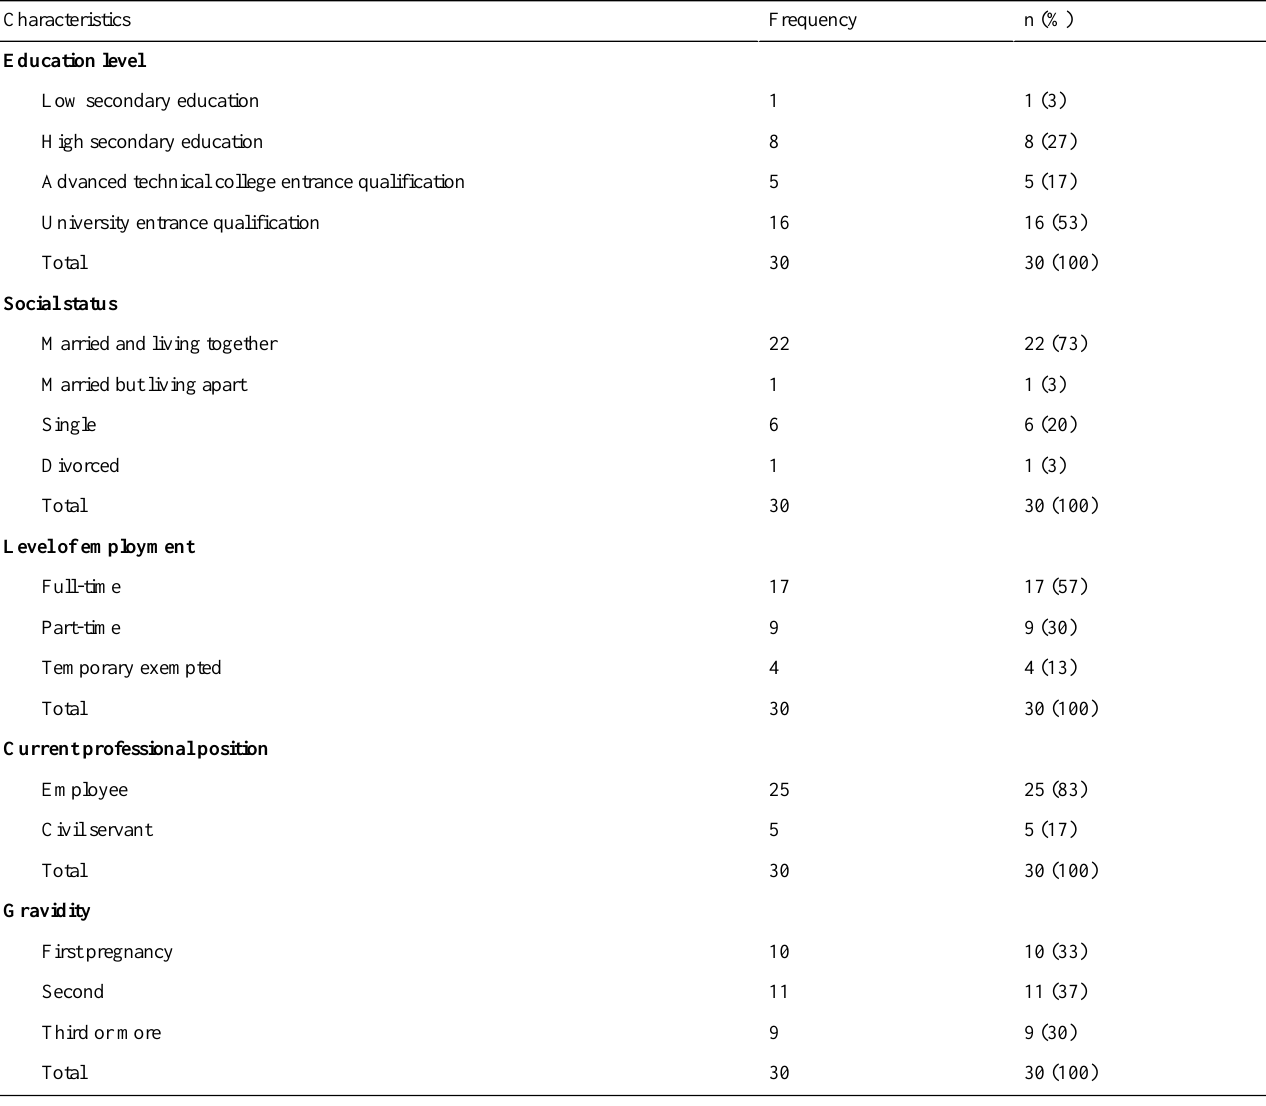
Table 1. Sample characteristics (N=30).